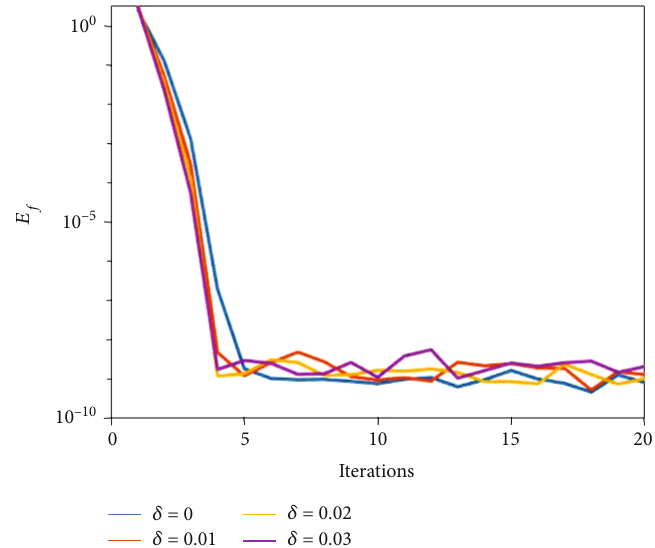
Figure 11: Concentration pro fi le for di ff erent values of Sc when λ = 0 : 1, N = 0 : 5, n = 0 : 5, f = δ = NR = 0 : 2, Sc = 0 : 6, and Pr = 1